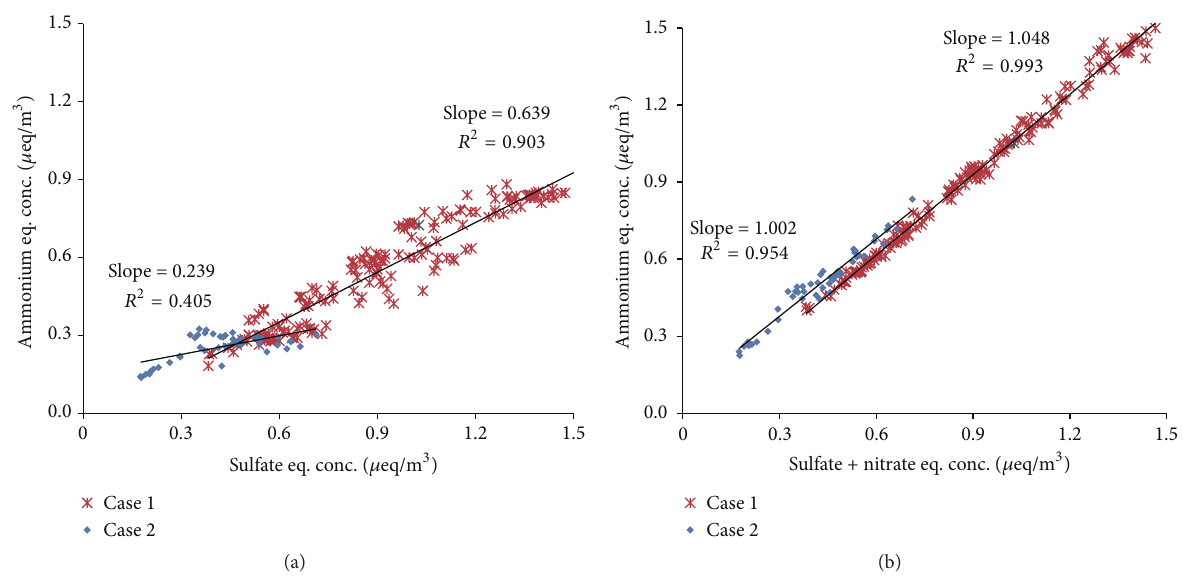
Figure 8: Correlation between equivalent concentration of ammonium and equivalent concentration of (a) sulfate and (b) sulfate + nitration in Case 1 and Case 2